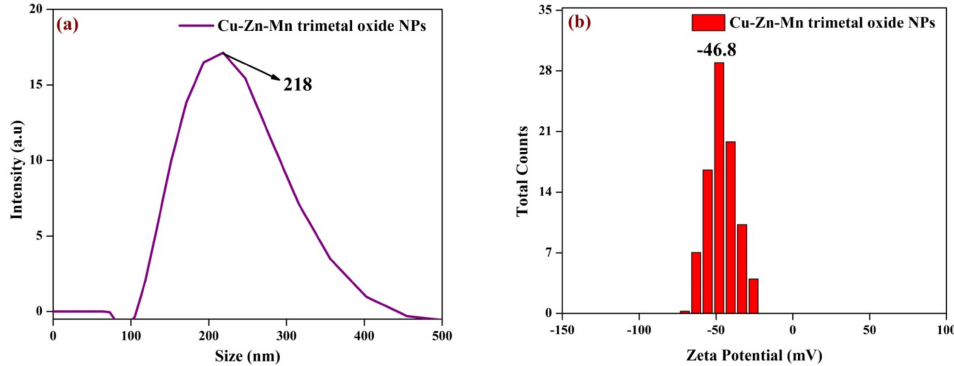
Figure 7. ( a ) Particle size and ( b ) Zeta potential of Cu-Zn-Mn mixed trimetal oxide nanoparticles.